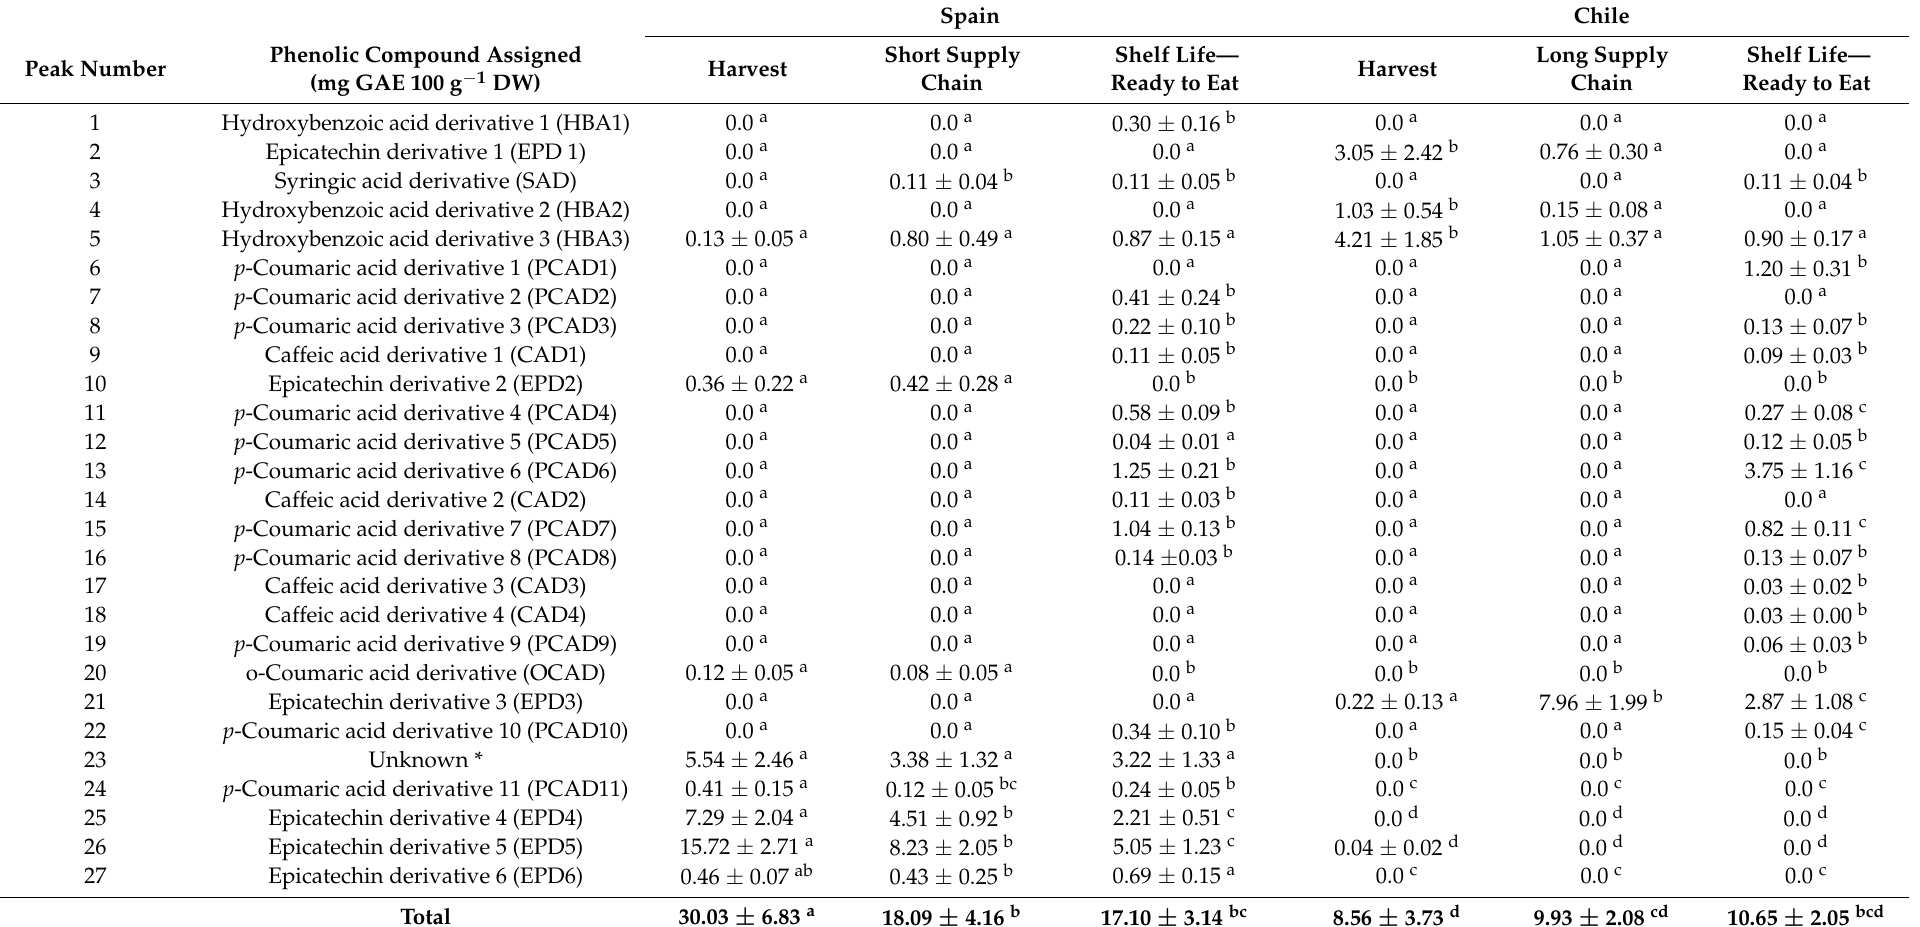
Table 4. Phenolic compound profile in Hass avocado from two countries (Spain and Chile) at harvest, after short and long-supply chain, and at the ready-to-eat stage. The results are expressed as the mean value of 10 avocados ± standard error ( n = 10). (*) Quantified as p-Hydroxybenzoic acid. Different letters in the same row indicate significant differences ( p < 0.05) determined by an ANOVA followed by Tukey